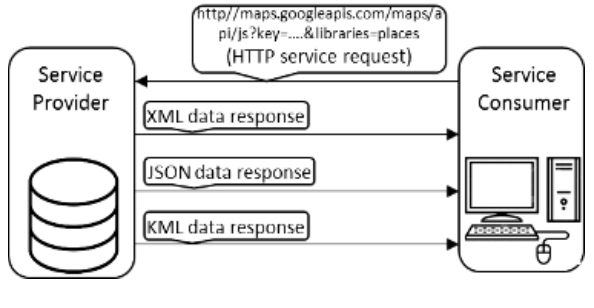
Figure 4. Web API data request and